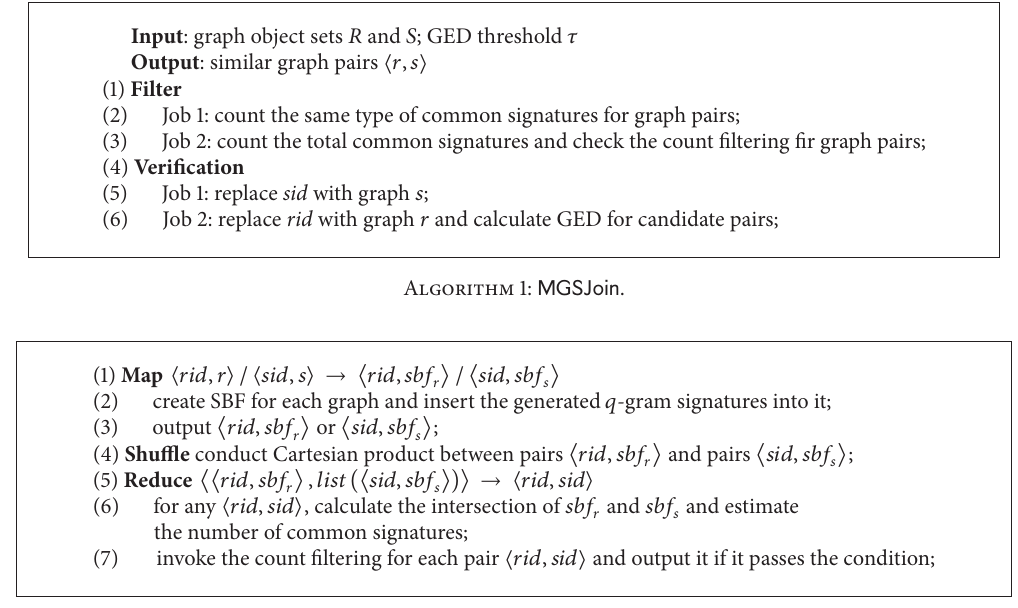
Algorithm 2: Replacement of filter of Algorithm